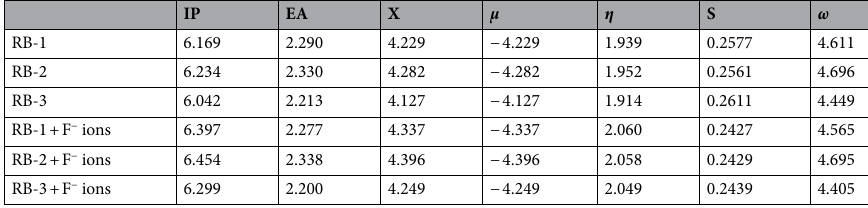
Table 3. Global reactivity parameters for RB-1, RB-1 + F − ions, RB-2, RB-2 + F − ions, RB-3, RB-3 + F − ions chemosensors for free and complex. IP , ionization potential; EA , electron affinity; X, electronegativity; μ , chemical potential; η , hardness; S , softness; ω, electrophilicity.